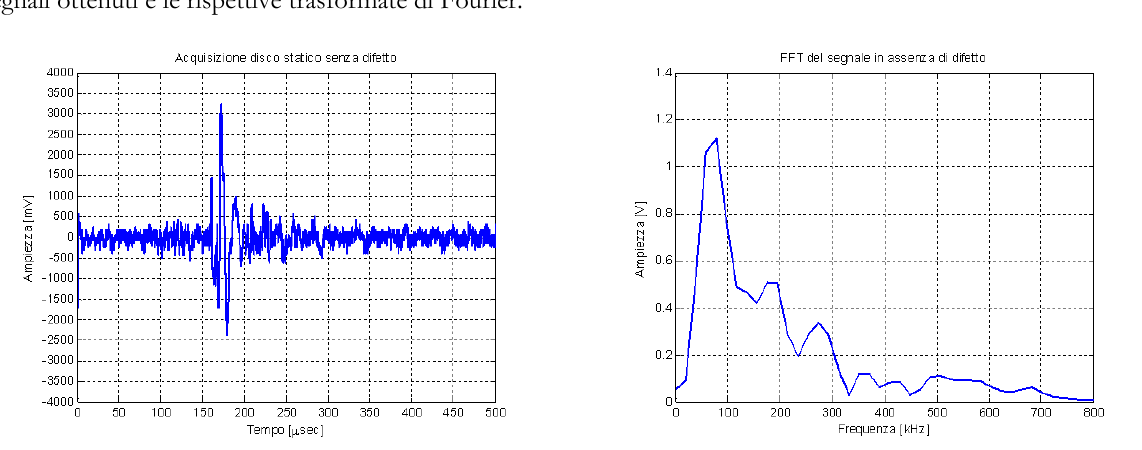
Figure 9. Signal acquired on the static disk, without defect, and its Fourier transform.